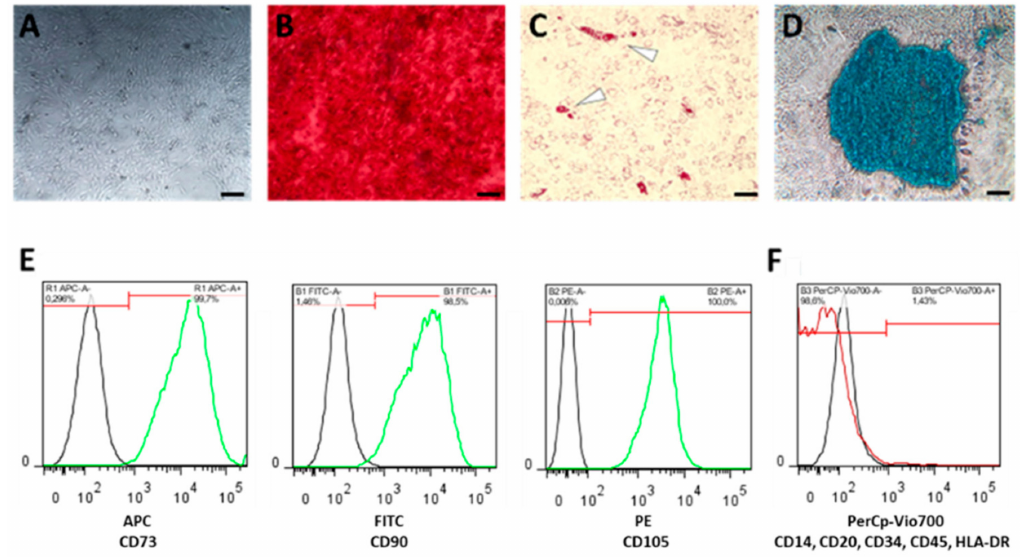
Figure 5. Bone marrow-derived human mesenchymal stromal cells (hMSCs) were characterized ( A ) by plastic adherence, and by their di ff erentiation capacity towards ( B ) osteogenesis using Alizarin Red staining, ( C ) adipogenesis using Oil-Red-O staining, ( D ) chondrogenesis using Alcian Blue staining (scale bars = 200 µ m), and ( E ) by the expression of surface marker CD105, CD90 and CD73, but the lack of (F) CD14, CD20, CD34, HLA-DR and CD45